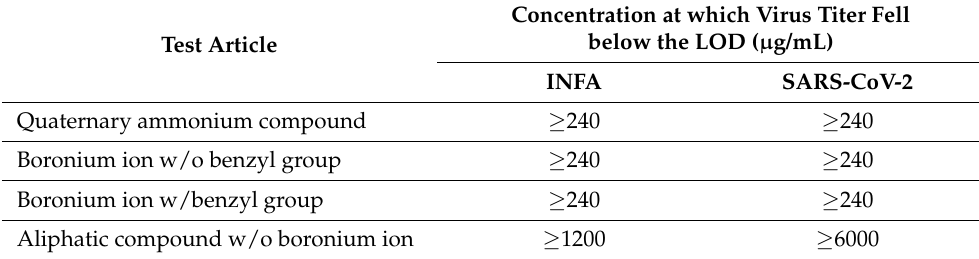
Table 1. Results of test article virus inactivation capability.